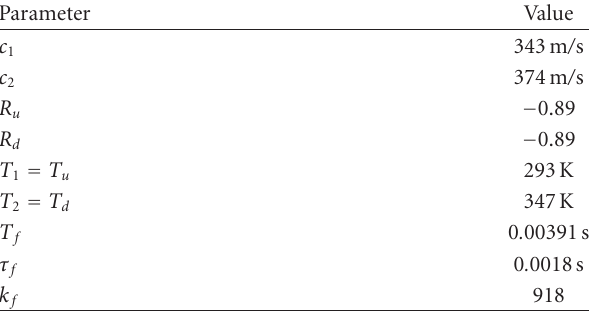
Table 2: Model parameters for the physical